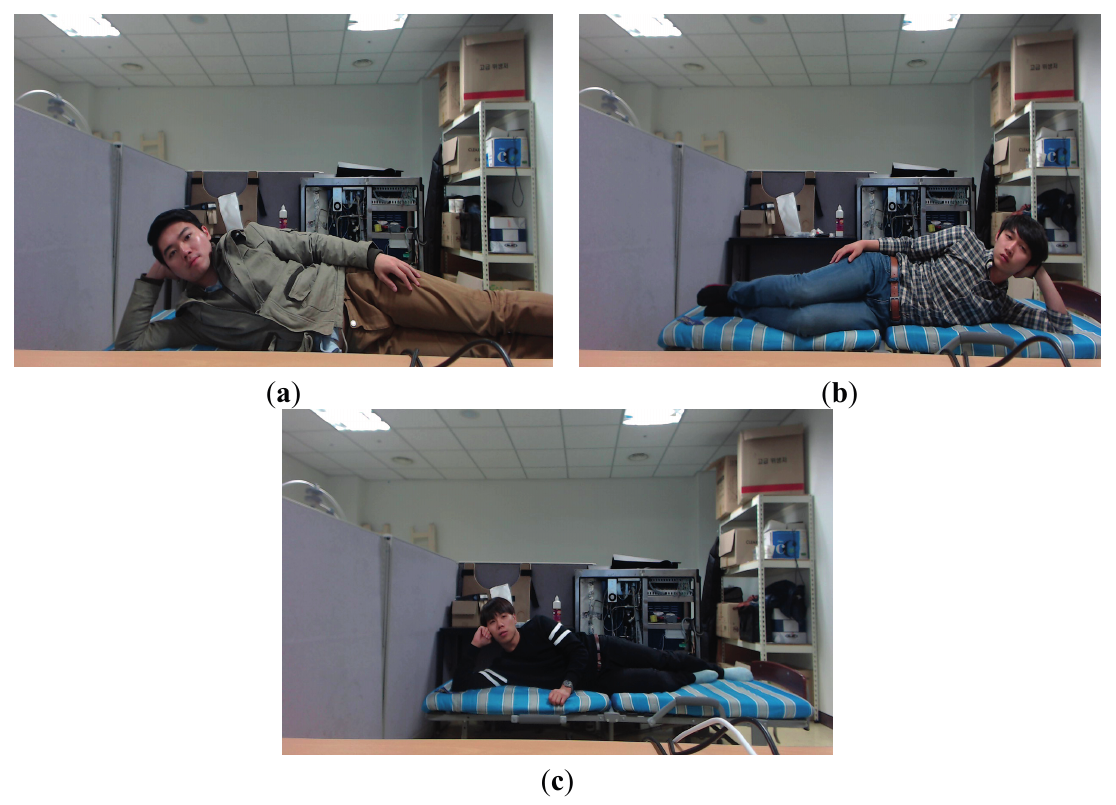
Figure 18. Examples of the images where each person is lying on his/her side. Image where a person is lying in the ( a ) left direction at the Z distance of 1.5 m; ( b ) right